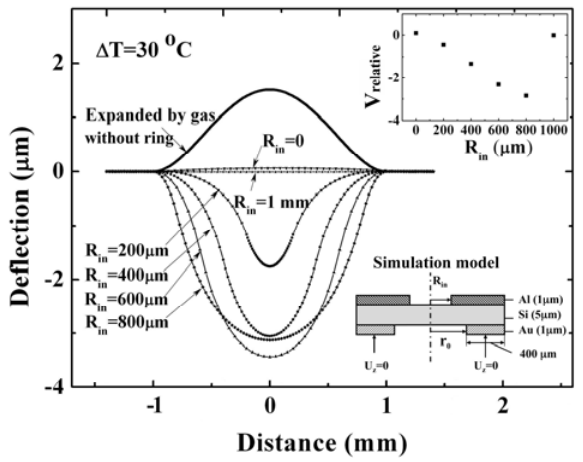
Figure 7. The deflection along diaphragm diameter without Al ring expanded by sealed gas, and the deflection with Al ring simulated with ANSYS. The below right is simulation model; the upper right is the normalizing volume change (with Al ring) relative to the volume change due to the expanded deflection. The temperature change is 30 °C, the radius (R) is 1 mm.